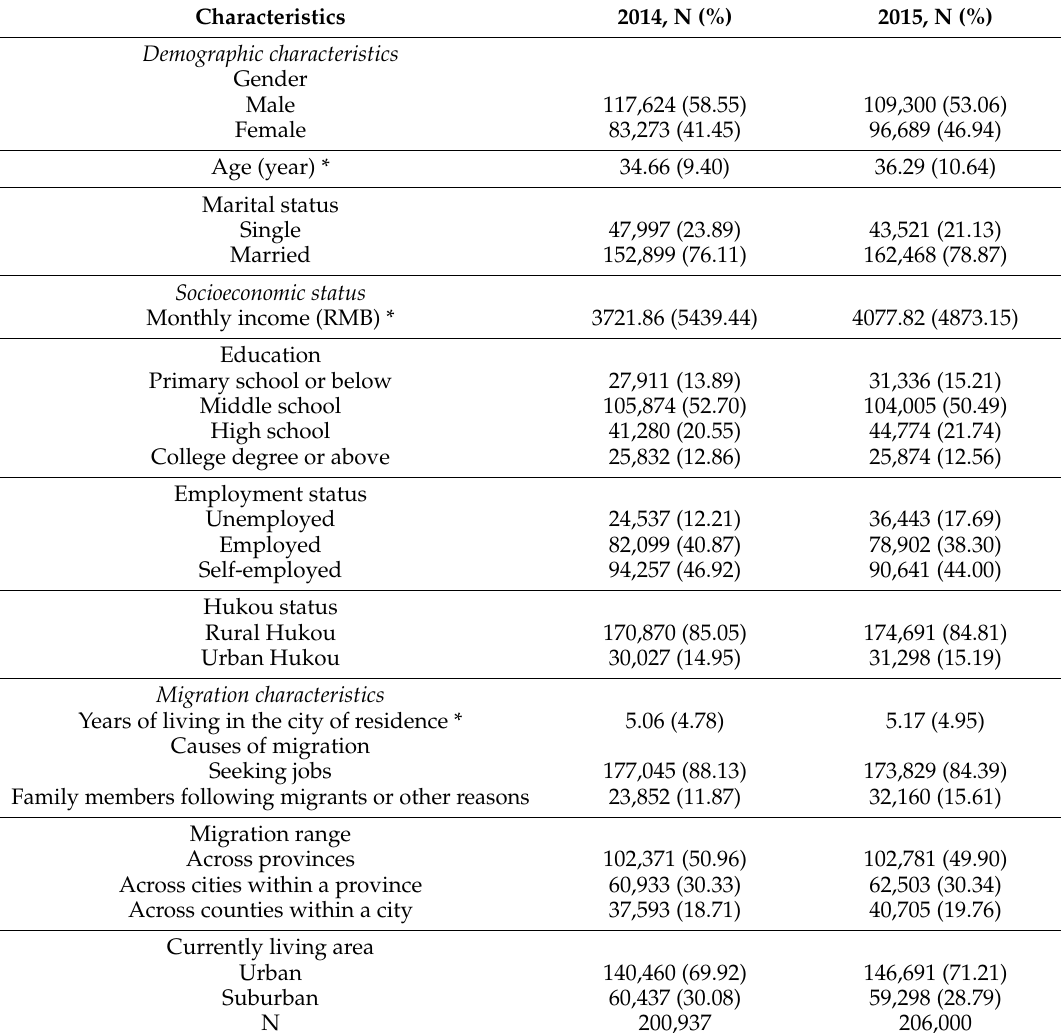
Table 1. Characteristics of the respondents in National Internal Migrants Dynamic Monitoring Survey (NIMDMS), 2014 and